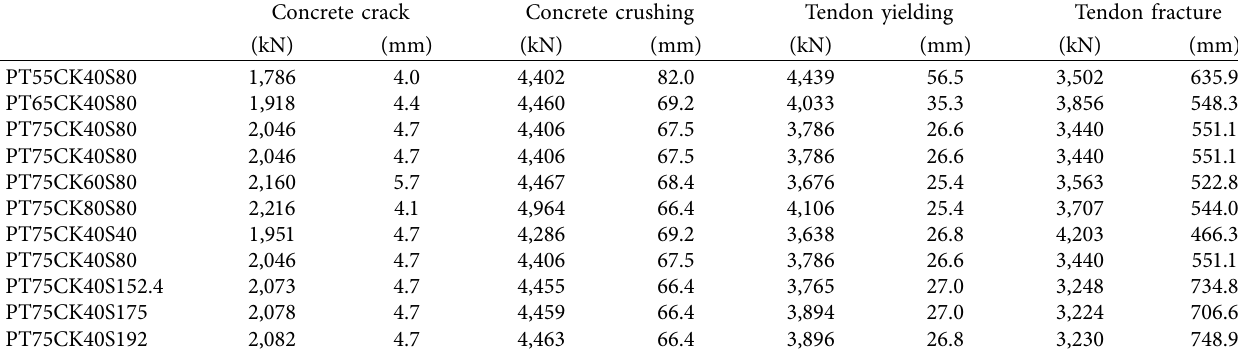
Table 8: M-Phi analysis result based on the proposed seismic evaluation criteria for the real-scale bridge piers. Concrete crack Concrete crushing Tendon yielding Tendon